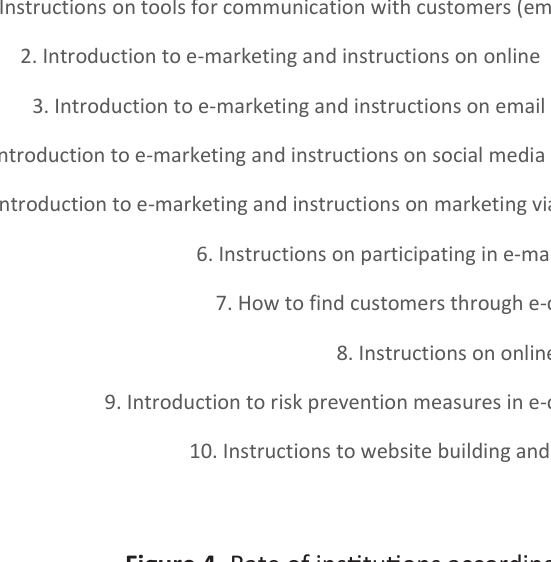
Figure 4. Rate of institutions according to options of training